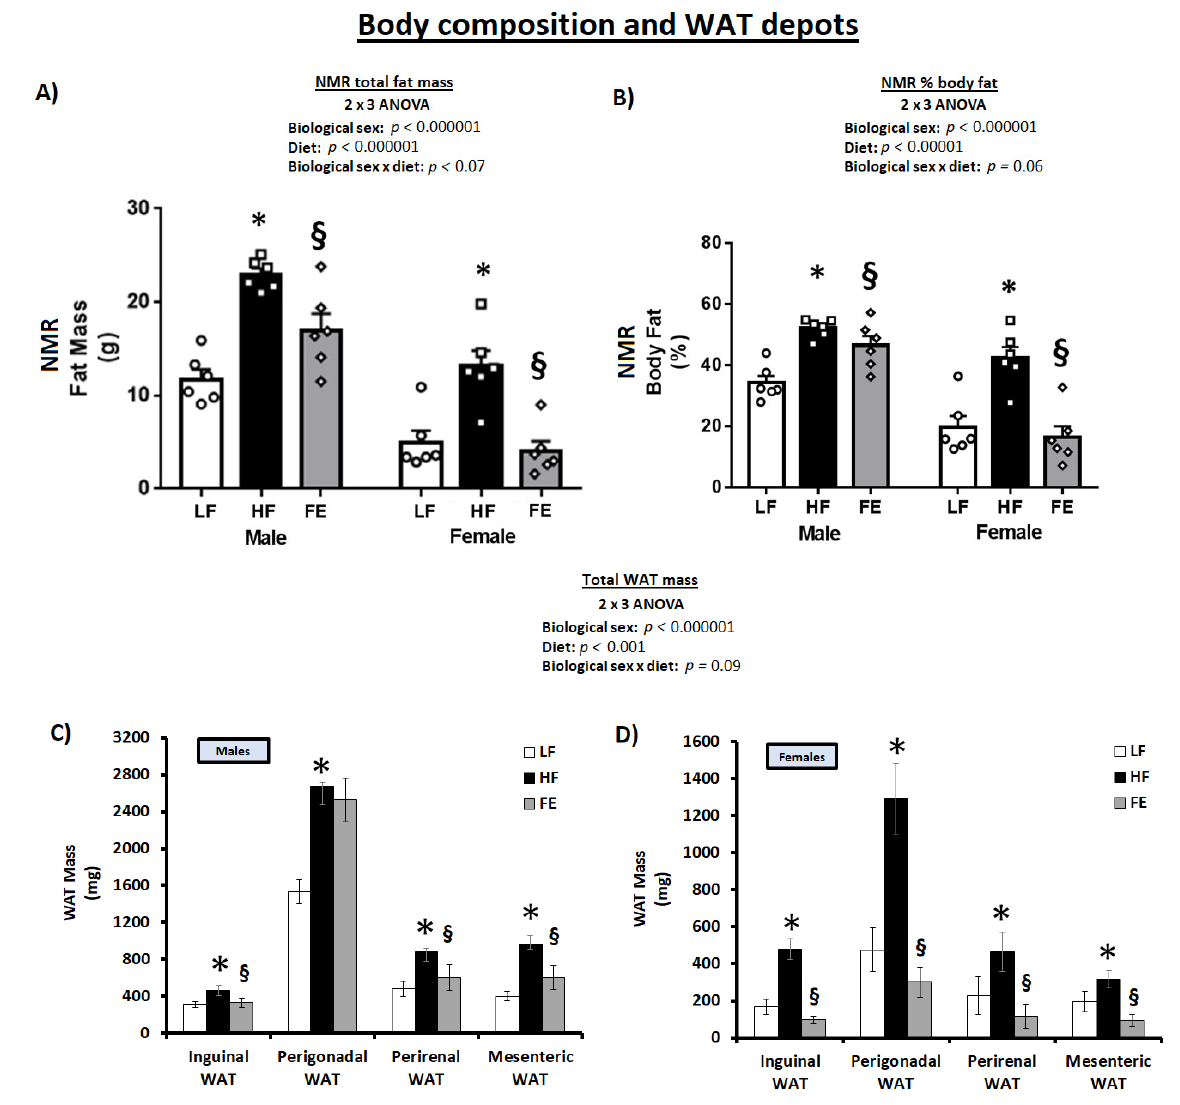
Figure 4. Effects of the ‘Fertility Enhancer’ supplement on total fat mass, % body fat, and WAT depots in Western diet-fed C57BL/6J mice. ( A ) Total fat mass from NMR. ( B ) Percentage body fat from NMR. ( C ) White adipose tissue mass in males. ( D ) White adipose tissue mass in females. * Significantly different from LF ( p ≤ 0.05). § Significantly different from HF ( p ≤ 0.05).